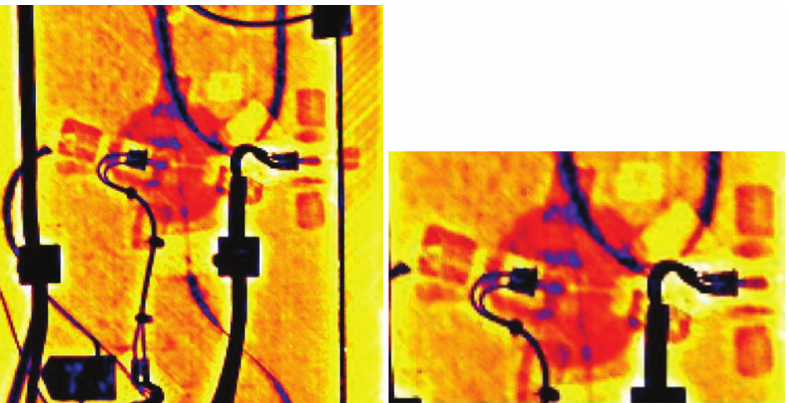
Figure 7 Phase image taken at 0.3 Hz stimulation frequency. A magnification of the embedded delamination can be seen on the right side with highlighting of the missed lower left part (blue arrow).